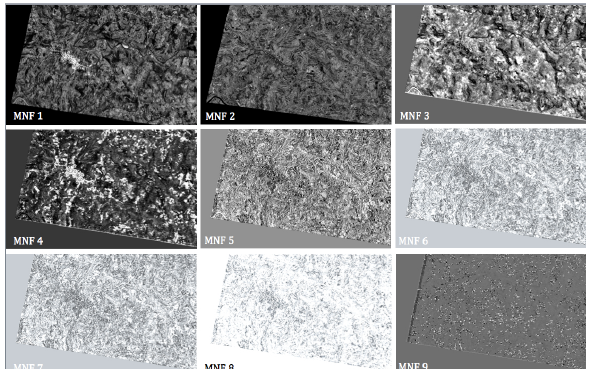
Figure 6. MNF transformation result sorted according to information coherent ;